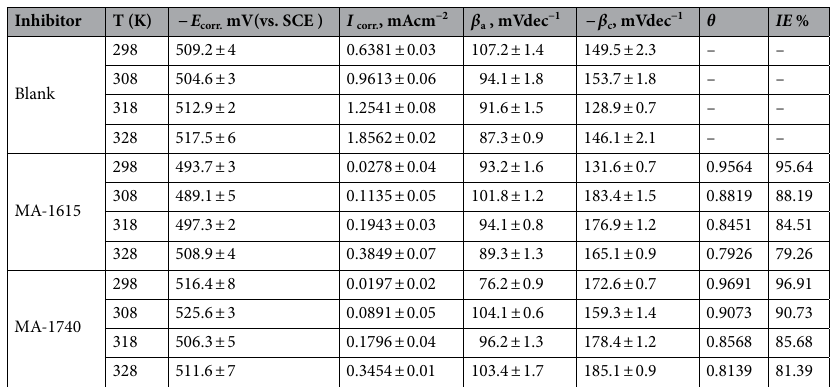
Table 4. Electrochemical kinetic parameters obtained from the polarization measurements on C-steel in uninhibited and inhibited acid solutions with optimum inhibitors doses at different temperature.